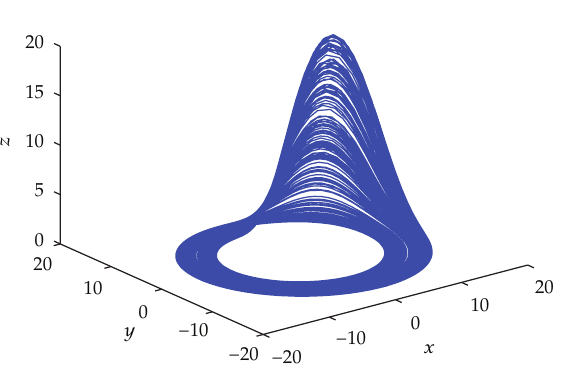
Figure 1: The chaotic behavior of time-delayed Rossler system.